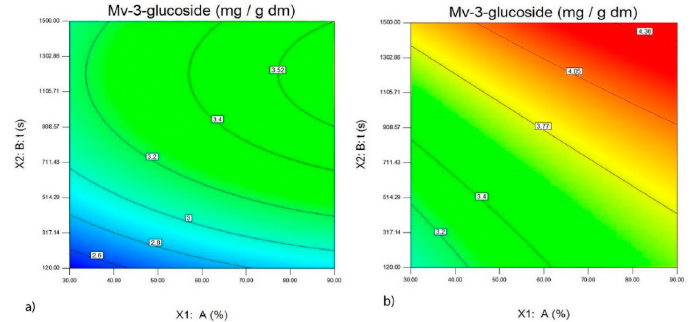
Figure 5. The effect of the probe with a diameter of 22 mm, amplitude A (%) and the time of Figure 5. The e ff ect of the probe with a diameter of 22 mm, amplitude A (%) and the time of ultrasound ultrasound extraction t (s) on the quantity of Mv-3-glucoside (mg/g d.m.) in the extracts of the wine extraction t (s) on the quantity of Mv-3-glucoside (mg / g d.m.) in the extracts of the wine lees of the lees of the Merlot variety ( a ) and the wine lees of the Vranac variety ( b ). Merlot variety ( a ) and the wine lees of the Vranac variety ( b